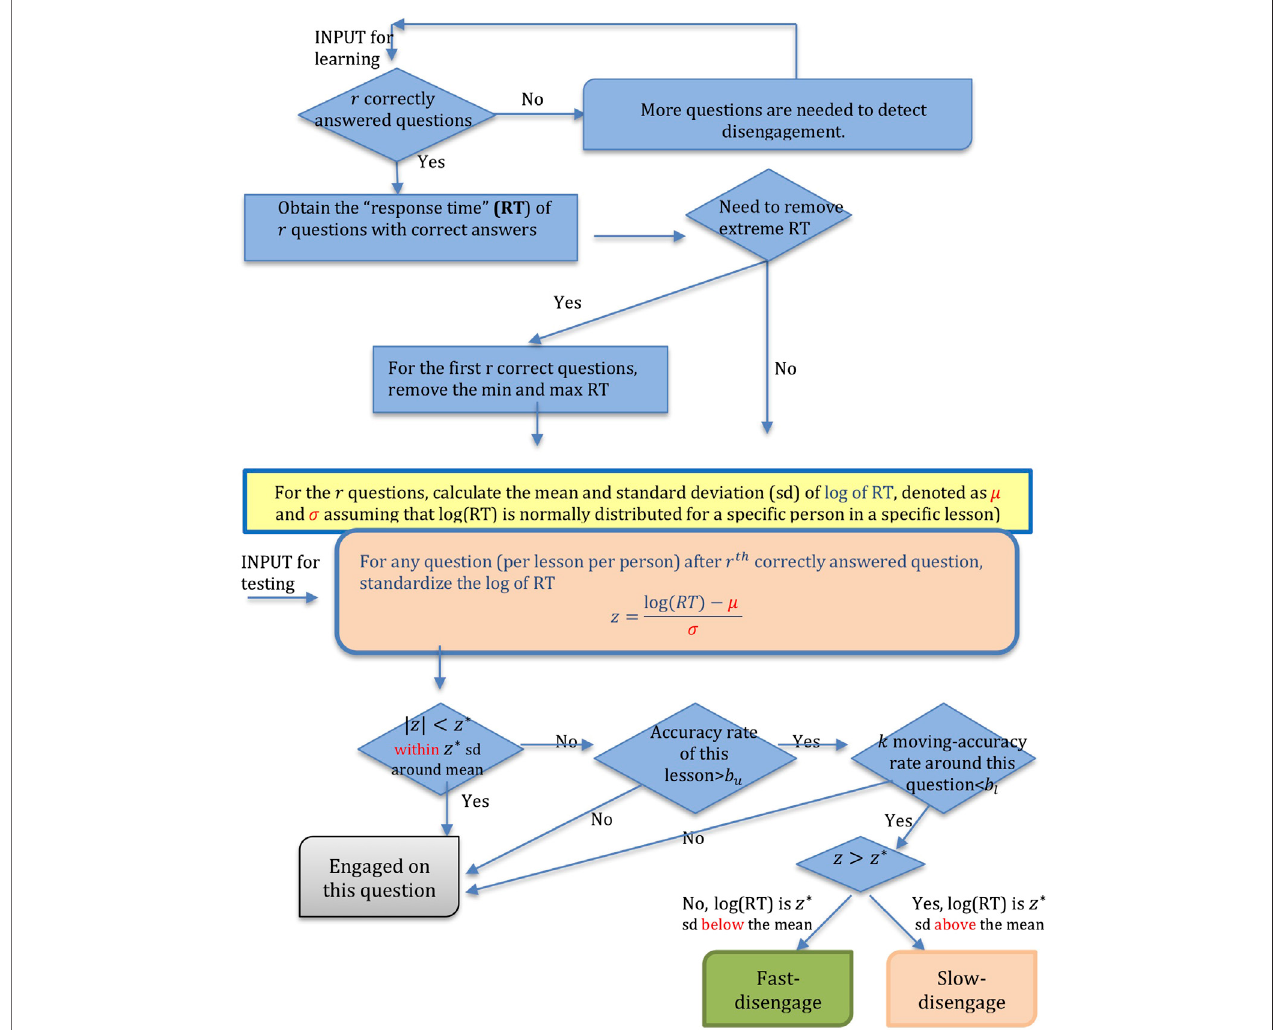
FIGURE 1 | Algorithm Flow Chart of Disengagement Tracing